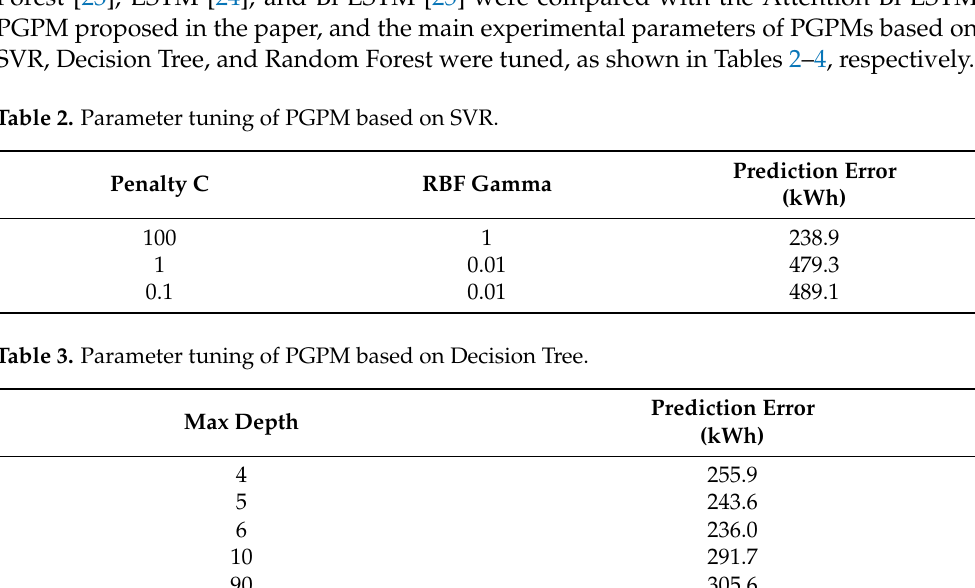
Table 3. Parameter tuning of PGPM based on Decision Tree. Table 4. Parameter tuning of PGPM based on Random